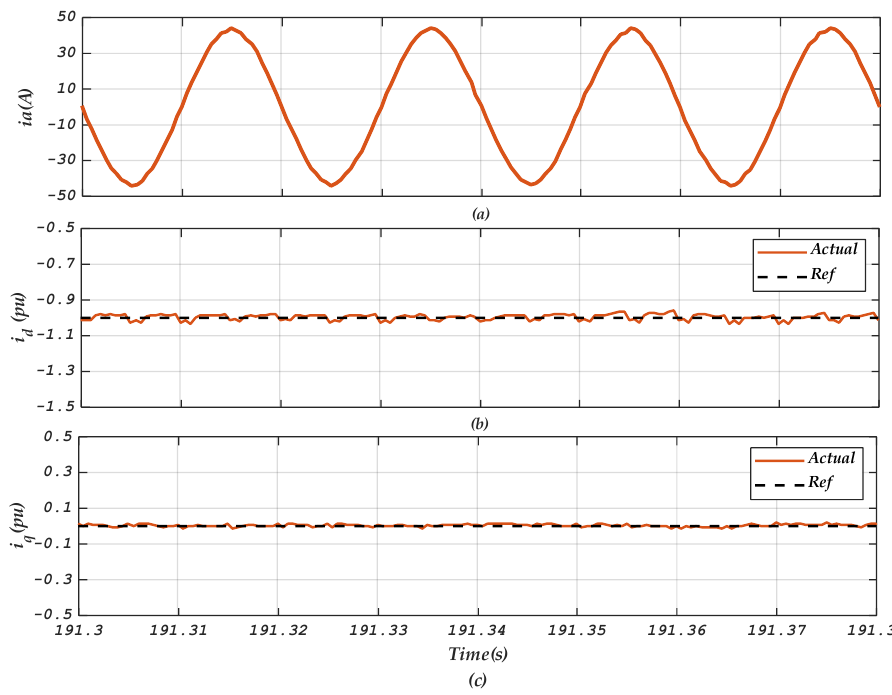
Figure 12. ( a ) Phase A current; ( b ) active current component 𝑖 𝑑 ; and ( c ) active current component 𝑖 𝑞 .